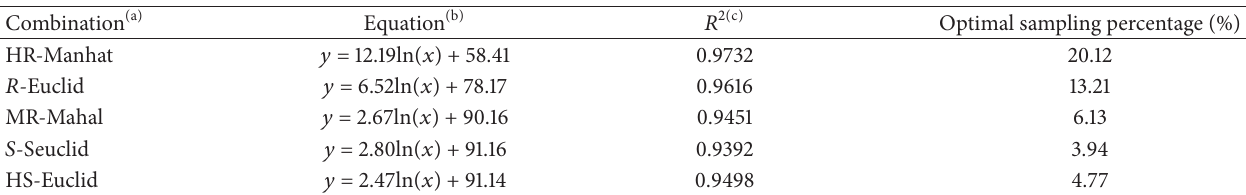
Table 2: The logarithmic equations on the CR’s value responded to the sampling percentage in five combinations of subcore collection construction. The optimal sampling percentage was calculated by the equation when the value of CR (%) was set to 95.00.